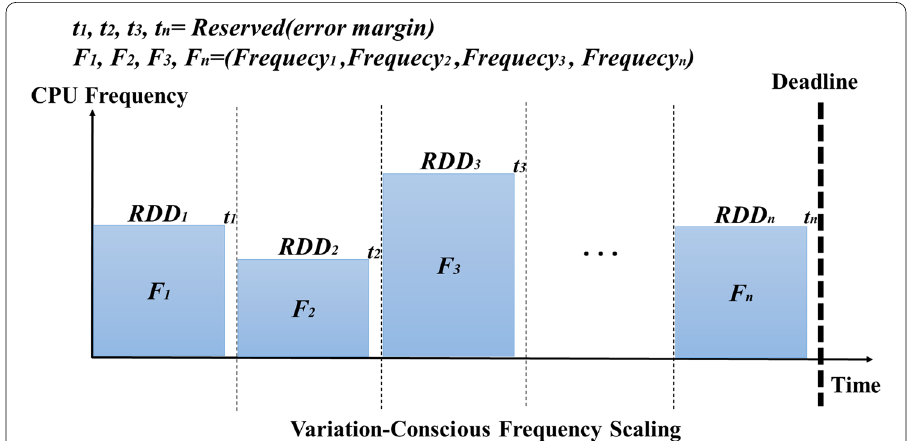
Fig. 5 Variation-conscious frequency scaling (our